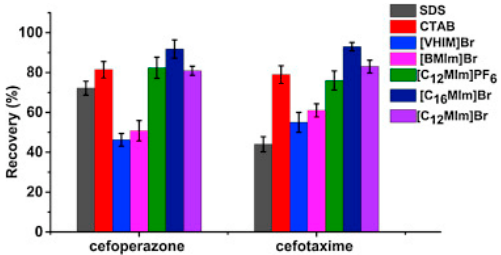
Figure 4. Comparison of the types of surfactants on the extraction efficiency of cefoperazone and cefotaxime. Figure adopted from the reference [121] with copyright permission.